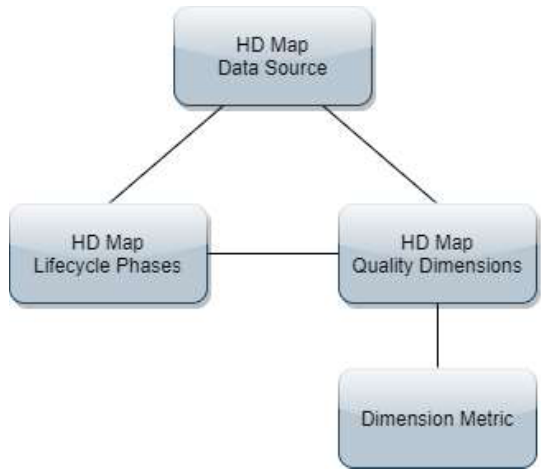
Figure 1. The pillars of Batini’s data quality model Using the data in an information system, the data quality approach extends to information quality. The demand against high-quality maps in self-driving has indicated a well- documented and quality-proved map database. This activity cannot ignore a sophisticated methodology covering regulations of capturing quality-oriented measures during data acquisition, processing, and map product